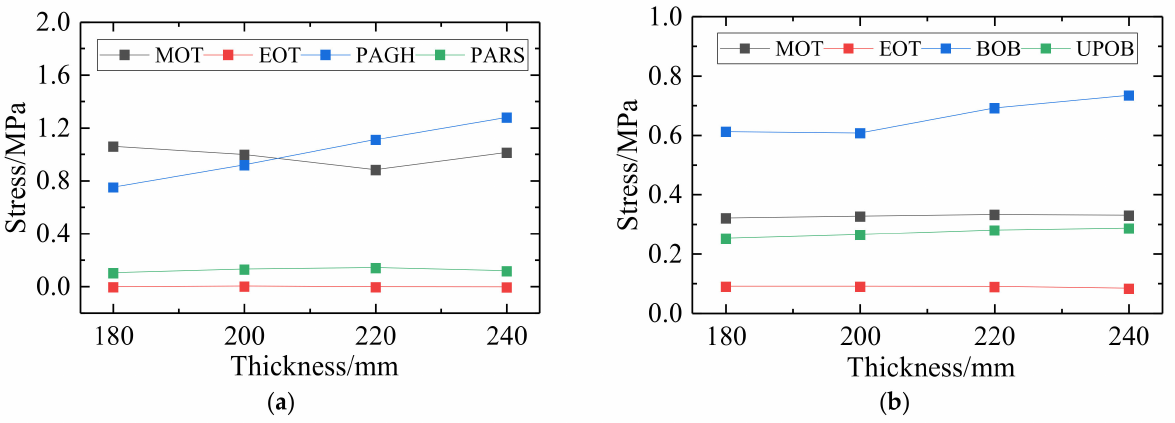
Figure 20. Maximum stress change curve of track structure under different thickness conditions: ( a ) Track slab; ( b ) Adjustment